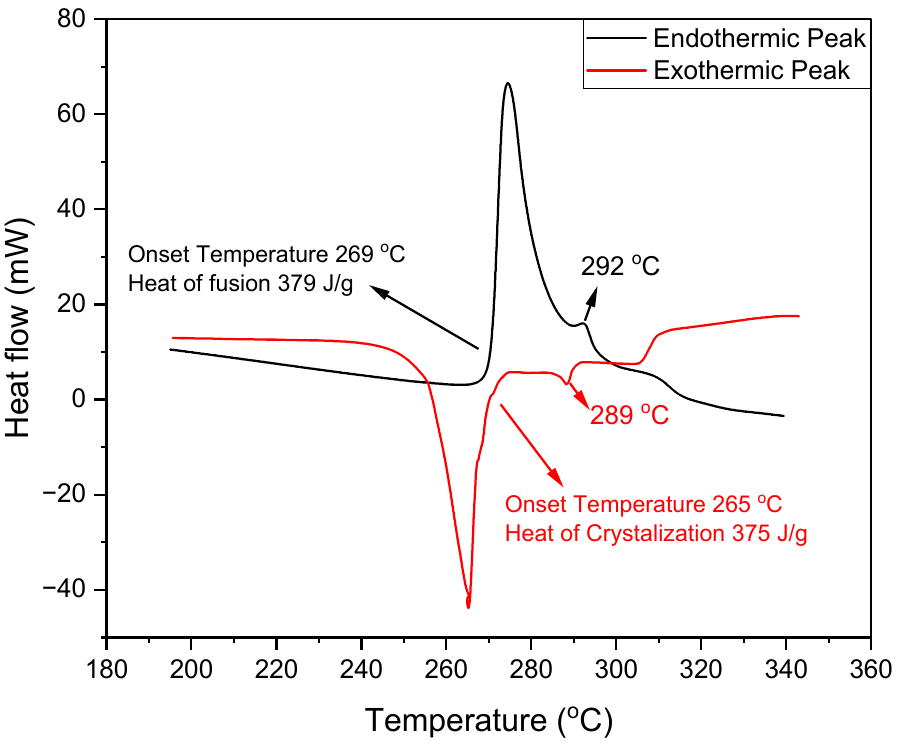
Figure 2. STA curve of 32 mol% LiCl-68 mol% LiOH indicating the melting temperature range and heat of fusion values.